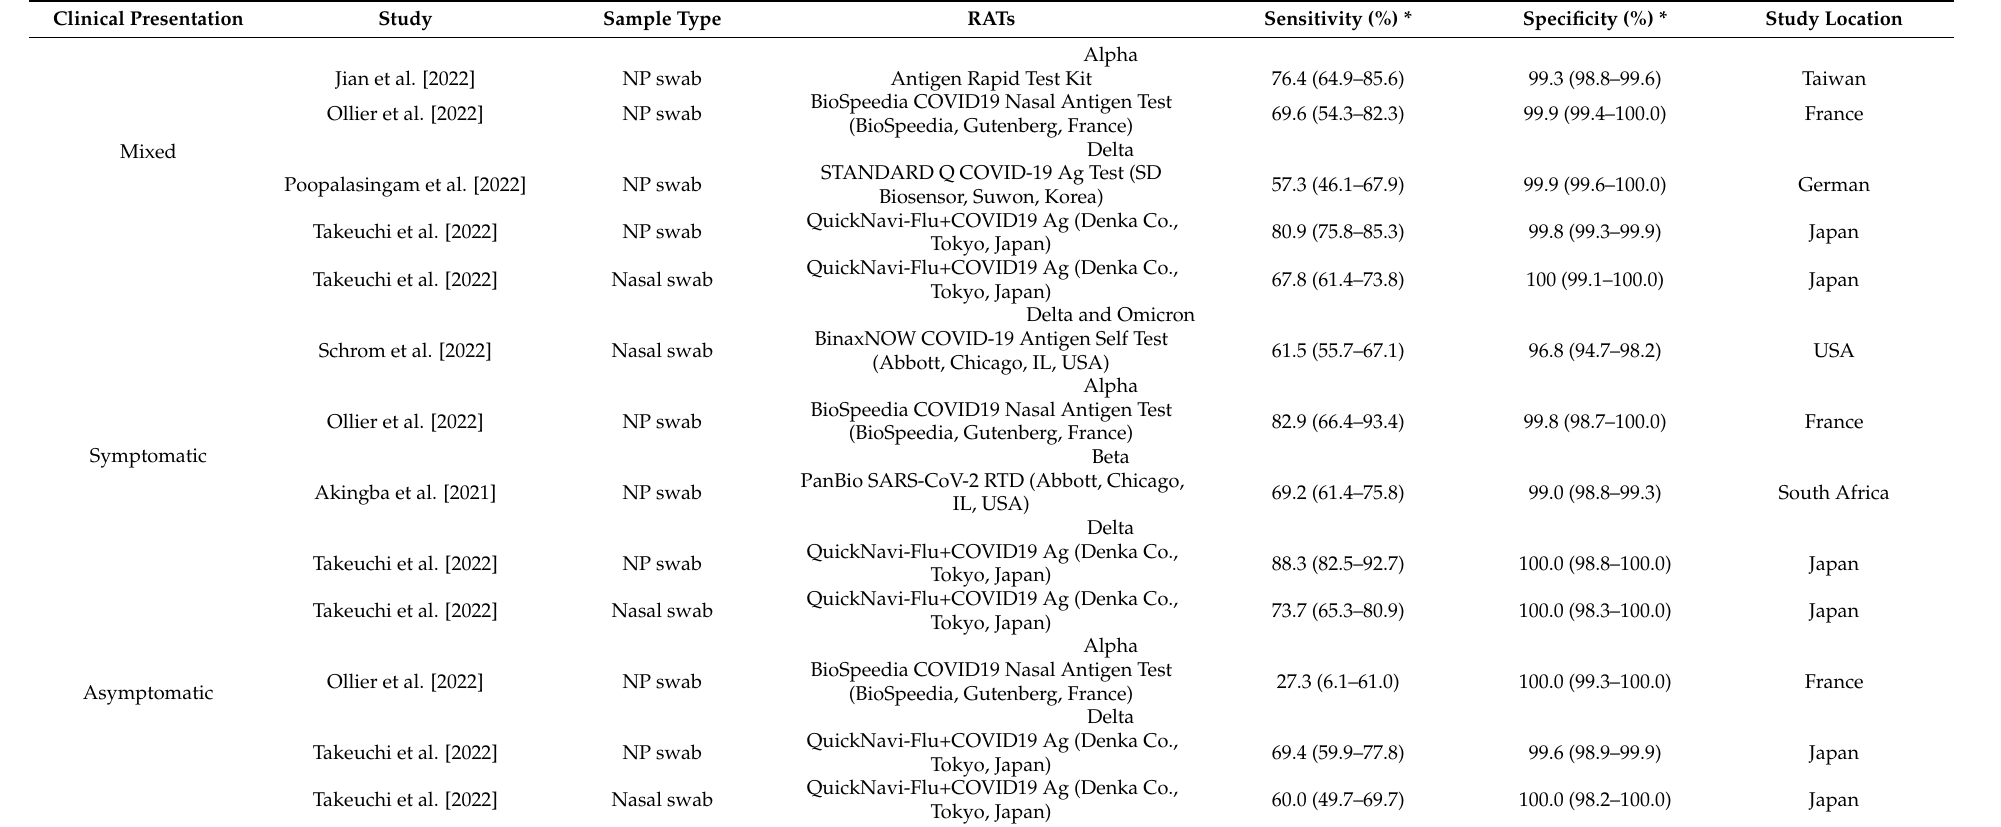
Table 2. Summary diagnostic accuracy data for RATs according to the clinical